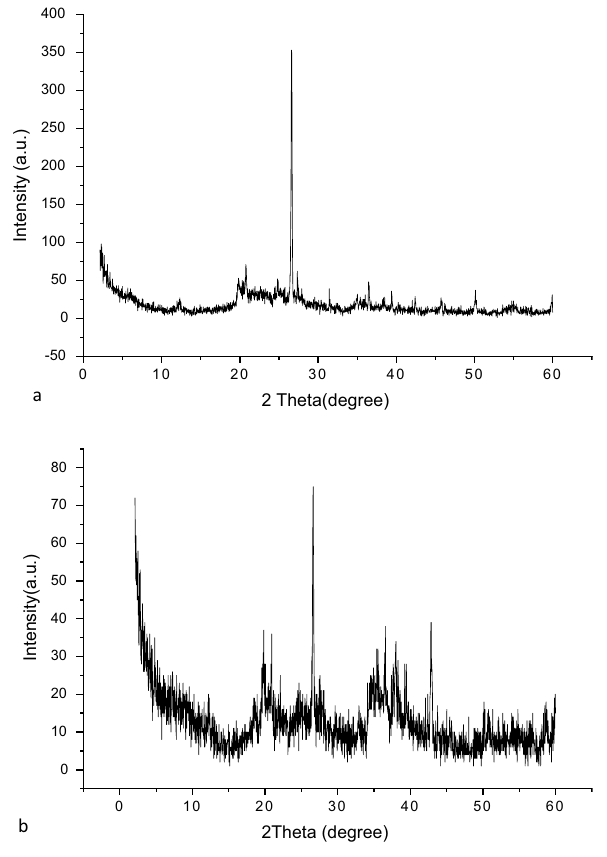
Figure 3. ( a ) Nano bentonite and ( b ) MgO impregnated clay XRD chromatogram after